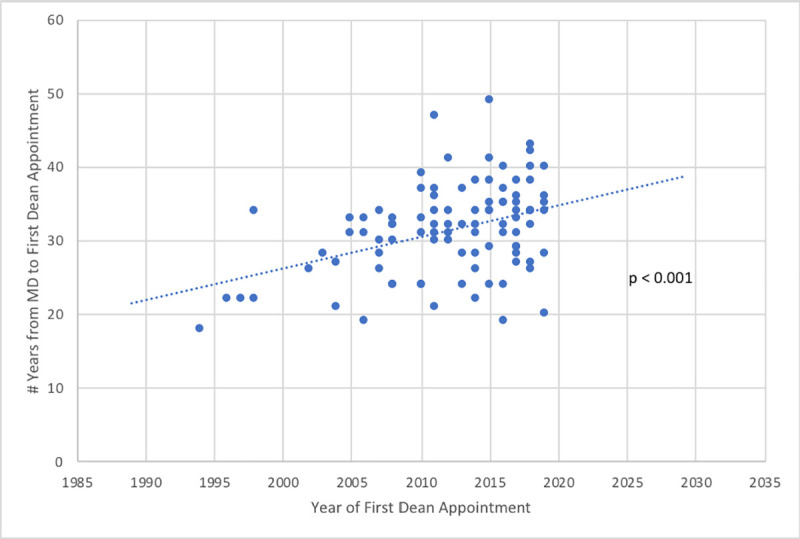
Progression through the pipeline.This figure depicts data from a study of Deans of U.S. Schools of Medicine (95 of 153 total whose CVs were available for review). On average, it takes 31.4 years for an individual to progress from their MD degree to their first Dean of Medicine position. In more recent years, however, it has taken longer to reach Dean of Medicine than it did previously (F-test from general linear model, p < 0.001).